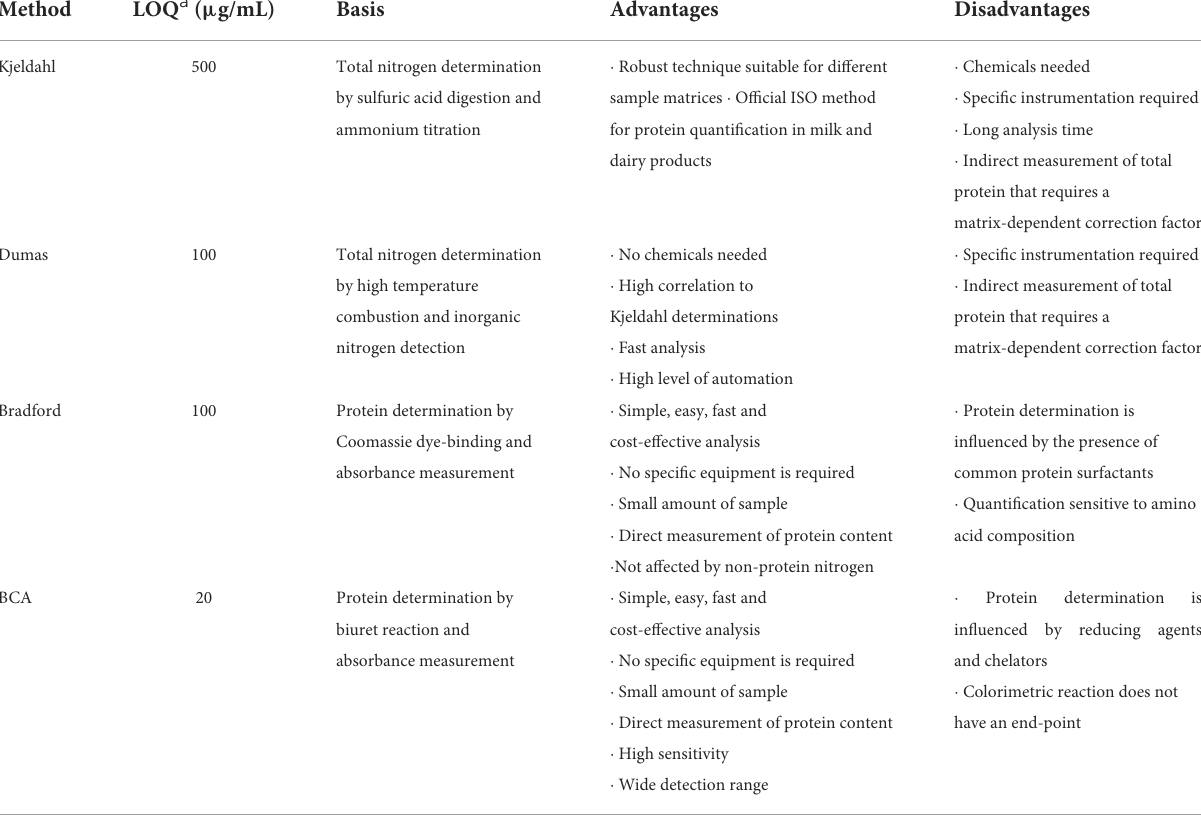
TABLE 1 Advantages and disadvantages of the most commonly used methods for total protein determination.